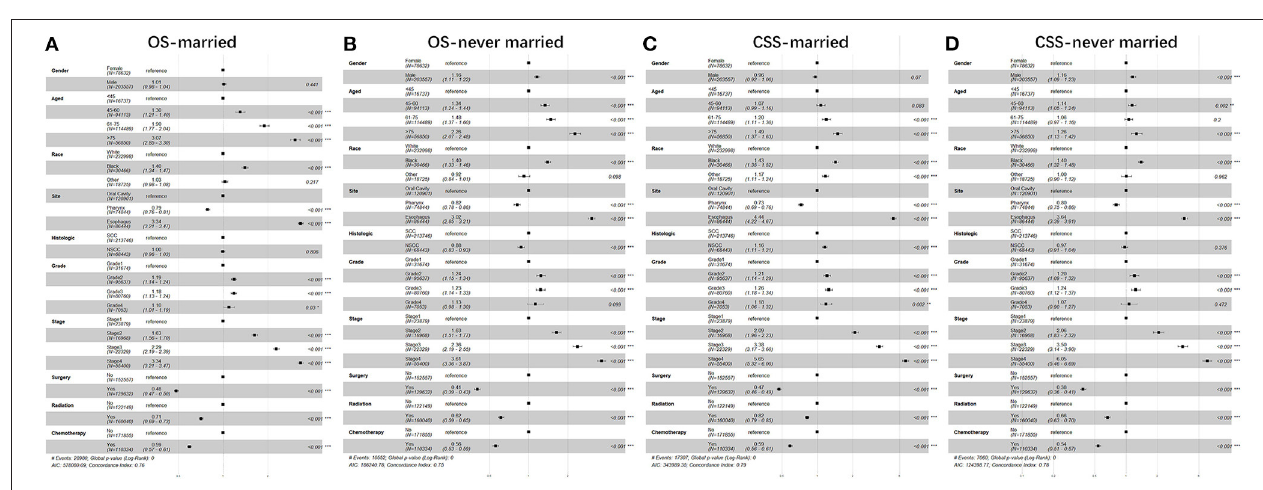
FIGURE 5 | The forest plot of HR (95% CI) for OS and CSS of the patients with UDTT in subgroups of married and never married. HR, hazard ratio; CI confidence interval; (A) OS of married; (B) OS of never married; (C) CSS of married; (D) CSS of never